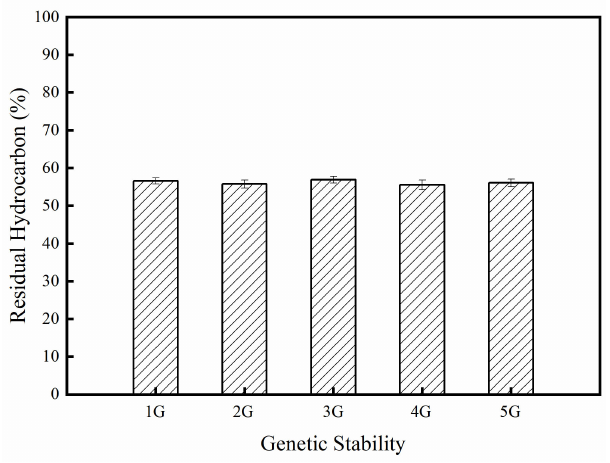
Figure 6. TPH removal efficiency by analysis of strain genetic